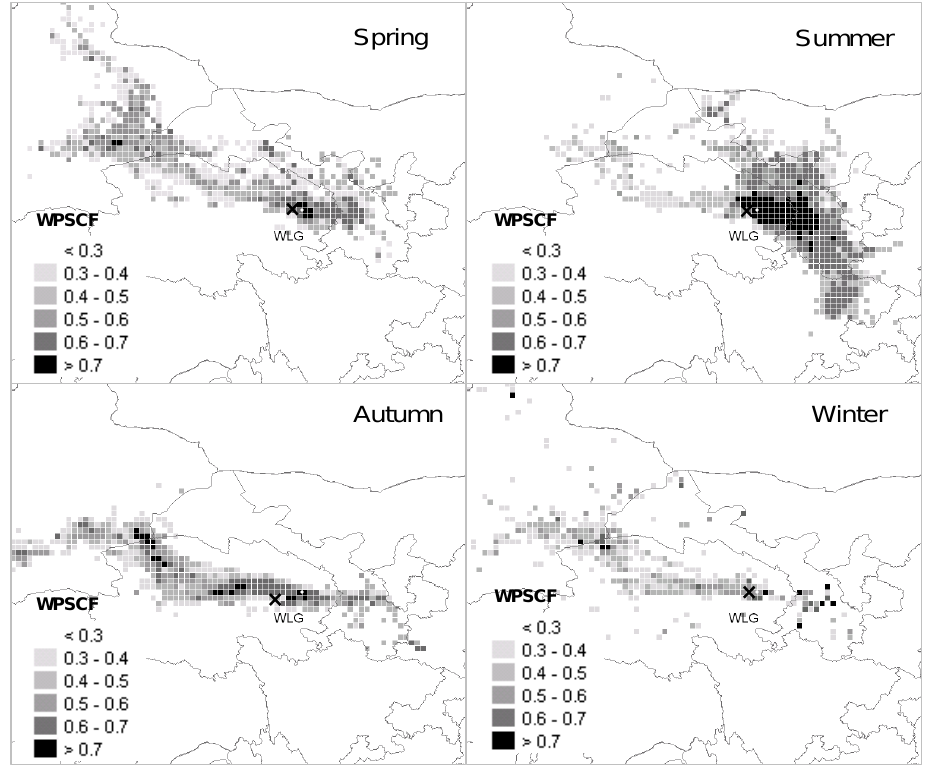
Fig. 11. Potential source regions calculated from trajectory statistics during July 2004–June 2007. WPSCF values have an arbitrary unit, higher vales (e.g. WPSCF > 0.6, the highest WPSCF should be 1) indicating a higher probability for a grid cell of CO